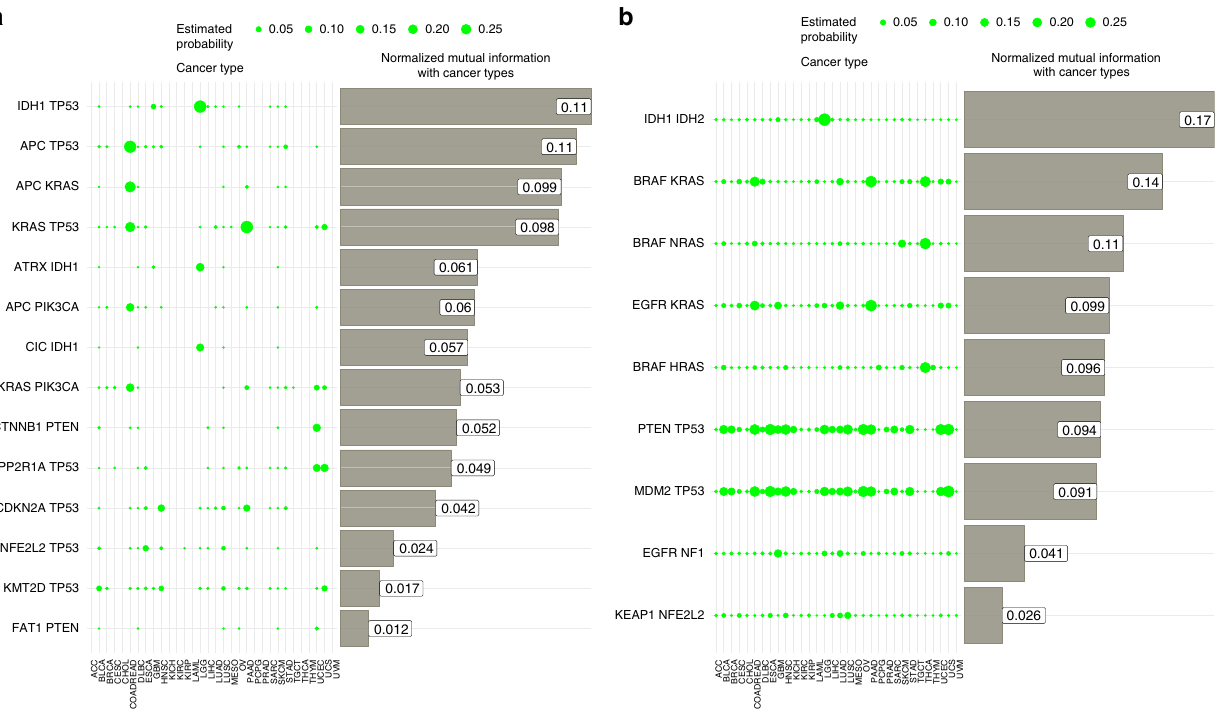
Fig. 5 The Good-Turing estimation of lineage-dependent gene co-mutation and mutual exclusivity probabilities. The probability of observing a gene co- mutation ( a ) or a mutation in one or the other but not both ( b ), as well as the dependency between the tissue type and these occurrence probabilities, as quanti fi ed by Normalized Mutual Information, varies substantially across gene